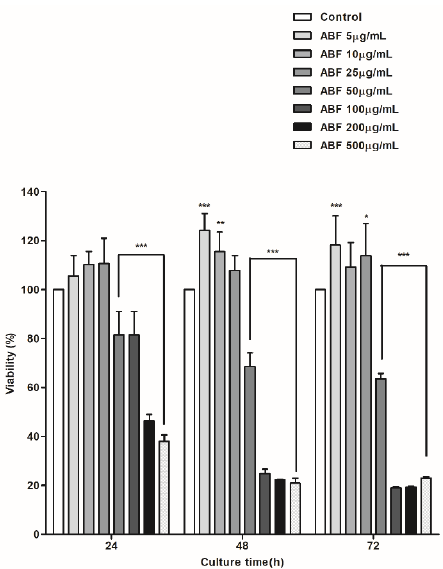
Figure 2. Cytotoxic effects of aronia bioactive fraction (ABF ® ) on BEAS-2B cells. Viability of BEAS-2B cells in response to different doses of ABF ® . Cells were incubated with ABF ® for 24, 48, and 72 h and then used for a 3-(4,5 dimethylthiazol-2-yl)-2,5-diphenyltetrazolium bromide (MTT) assay. The values are presented as means ± standard deviation (SD) of three independent experiments. * p < 0.1, ** p < 0.05, *** p < 0.01 indicate significant differences as compared to the control cells. Antioxidants 2020 , 9 , x FOR PEER REVIEW